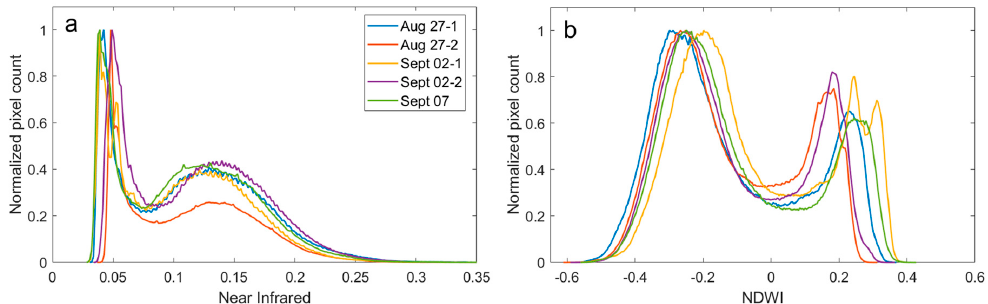
Figure 10. Normalized distribution of ( a ) top of atmosphere near infrared reflectance and ( b ) NDWI for Yukon Flats water bodies and surrounding vegetation in five different PlanetScope images. In the near infrared ( a ), water pixels are the left peak (lower band values) and in the NDWI ( b ), the second peak represents water pixels.